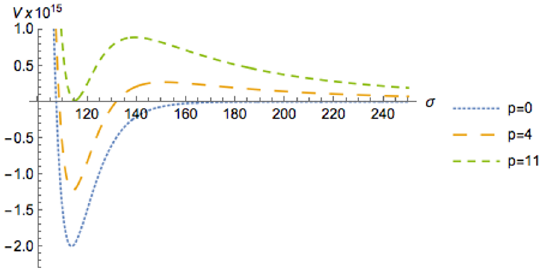
Figure 2. Plot of the potential (multiplied by 10 15 ), where W 0 = − 10 − 4 , A = 1 , a = 0 . 1 and the number of D 3 -branes are p = 0 (blue), p = 4 (yellow) and p = 11